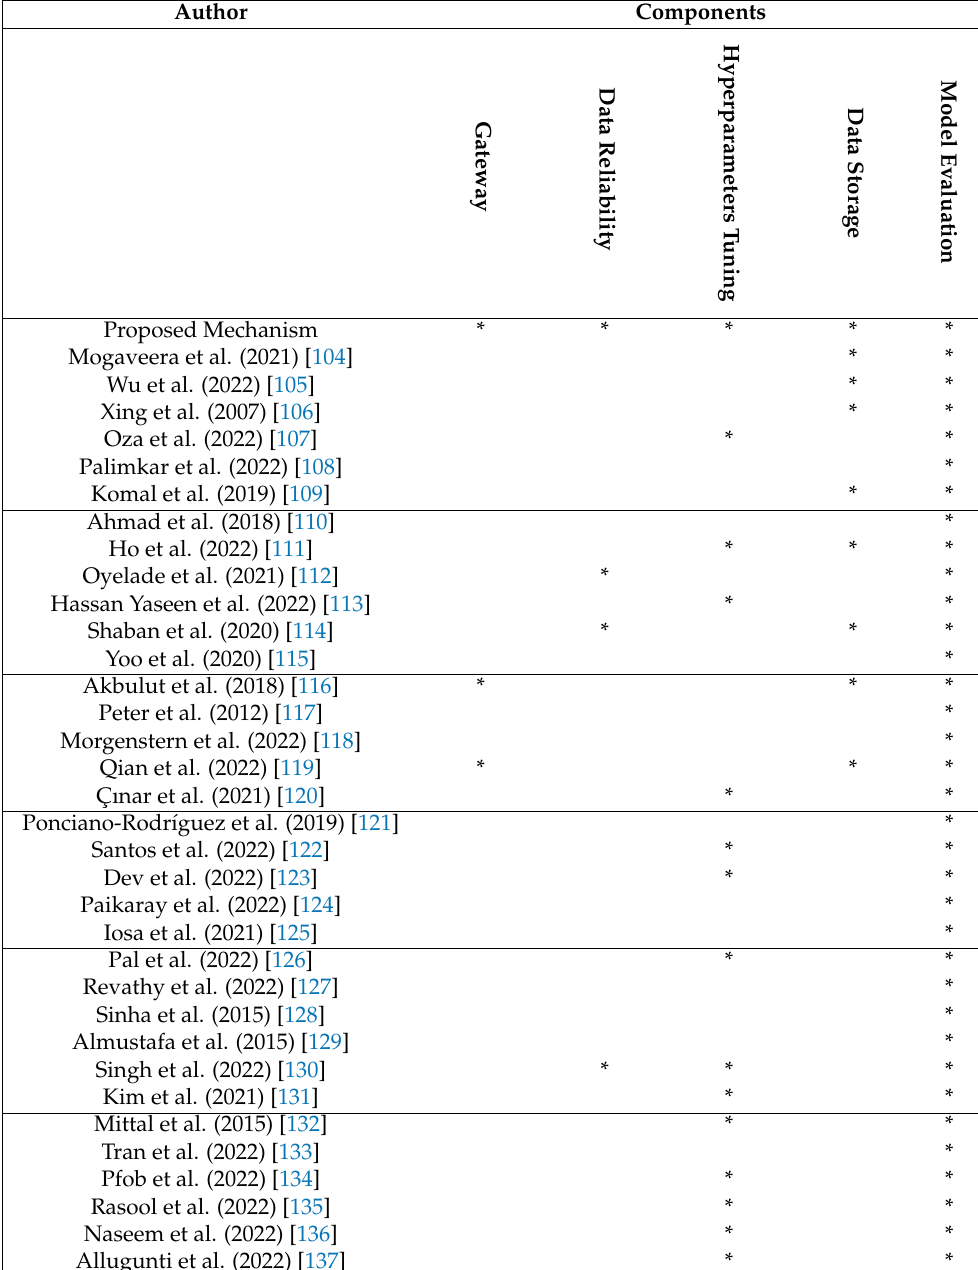
Table 17. List of existing research works based on the components (annotated with *) used for their